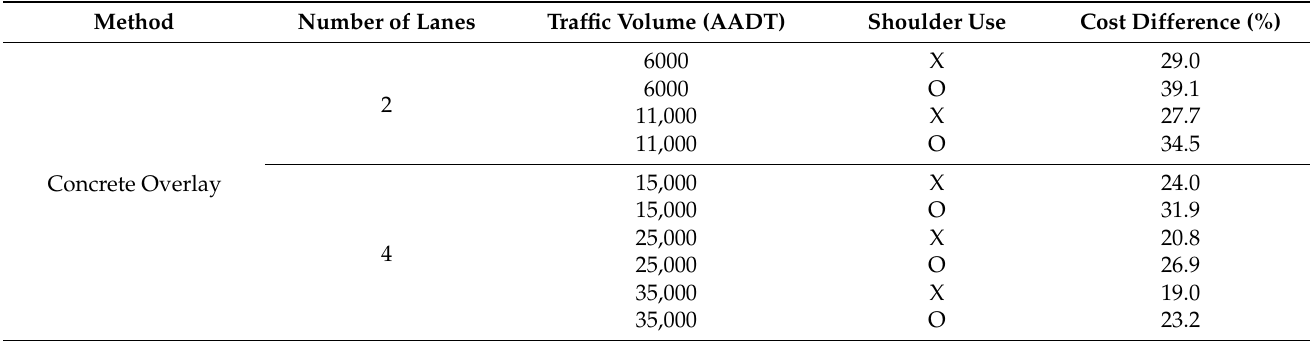
Table 4. Concrete Overlay Economic Efficiency.